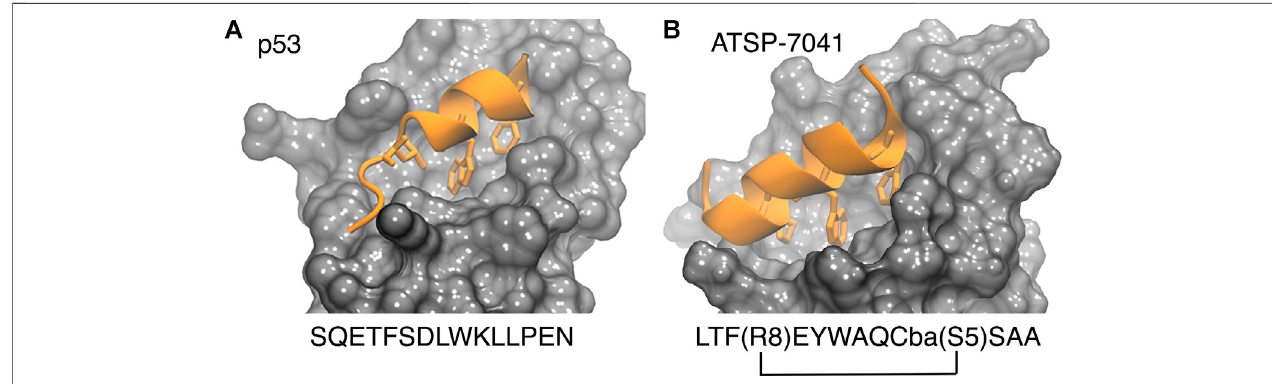
FIGURE2| P53( left ,PDB1ycr)andastapledpeptide( right ,MELDprediction)bindingMDM2.Threeanchoringhydrophobicresiduesinthepeptideasshownas sticks (orange). The cartoon representation shows the extended helix for the ATSP7041 stapled peptide.